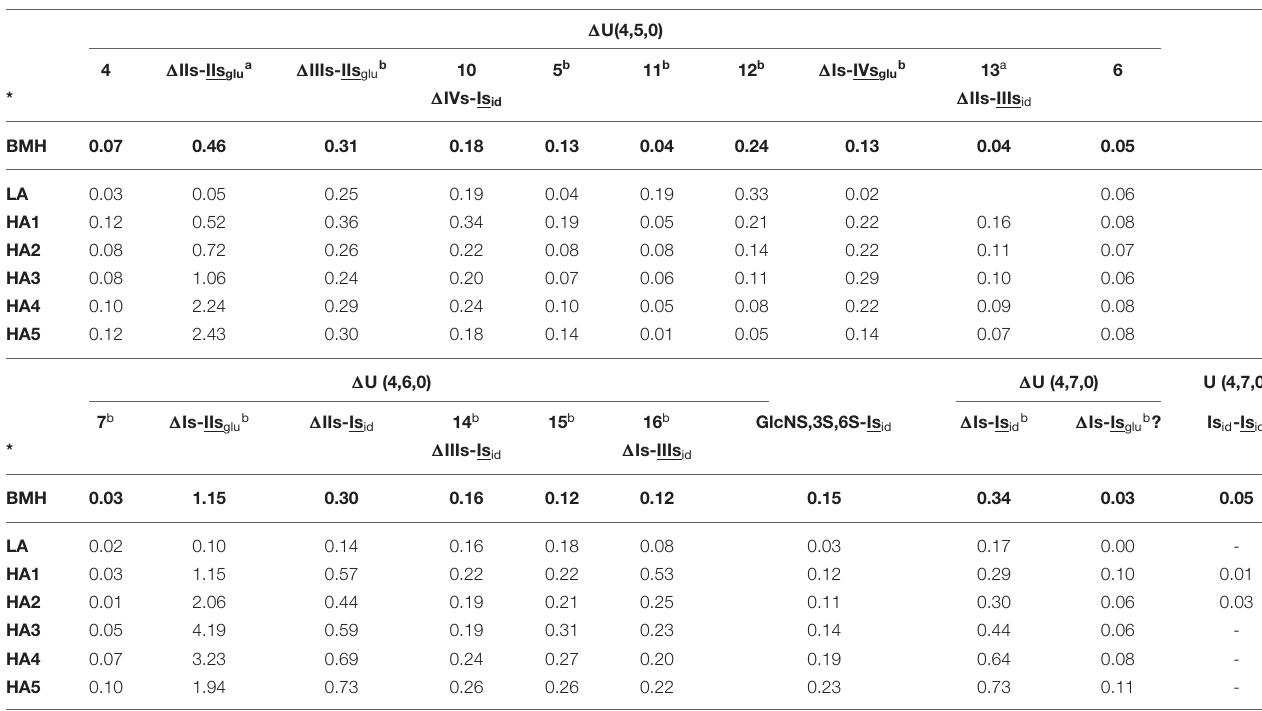
TABLE 5 | Quantification of 1 U(4,5,0) and 1 U(4,6,0) tetrasaccharide heparinase II-resistant building blocks (% w/w) for bovine mucosal heparin (BMH; starting heparin) affinity fractions using ion-pair liquid chromatography/mass